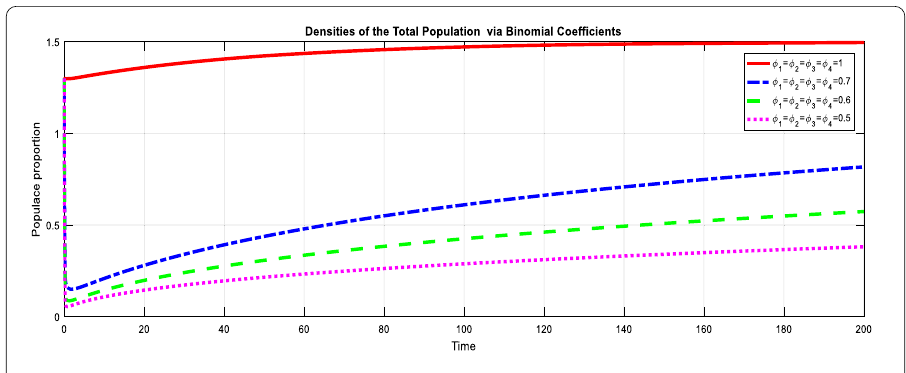
Figure 21 Dynamic of N ( t ) by varying the value of φ